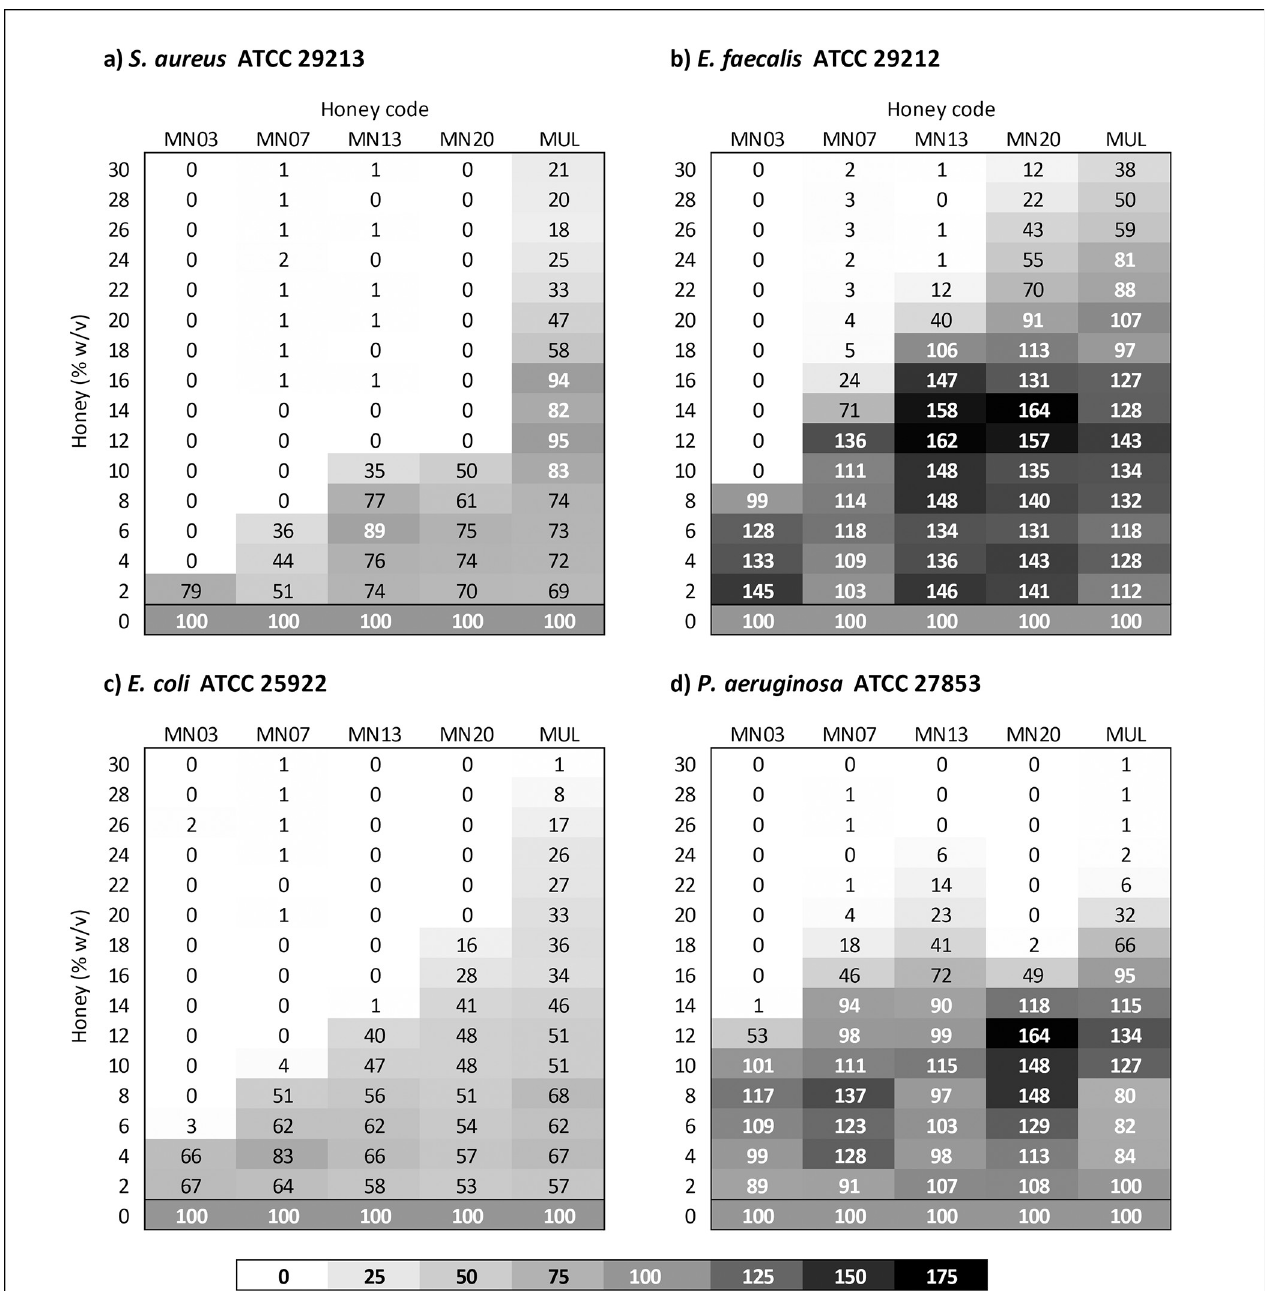
Fig 1. Heat maps of relative optical density at 24 h for selected manuka honeys and multifloral honey. Values indicate the relative optical density of wells containing honey compared to the positive control, expressed as a percentage.